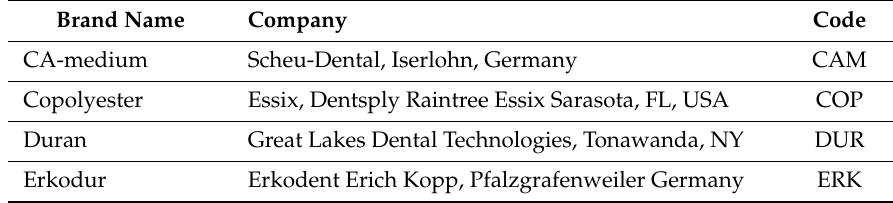
Table 1. Brand names, manufactures, and codes for all materials tested. Brand